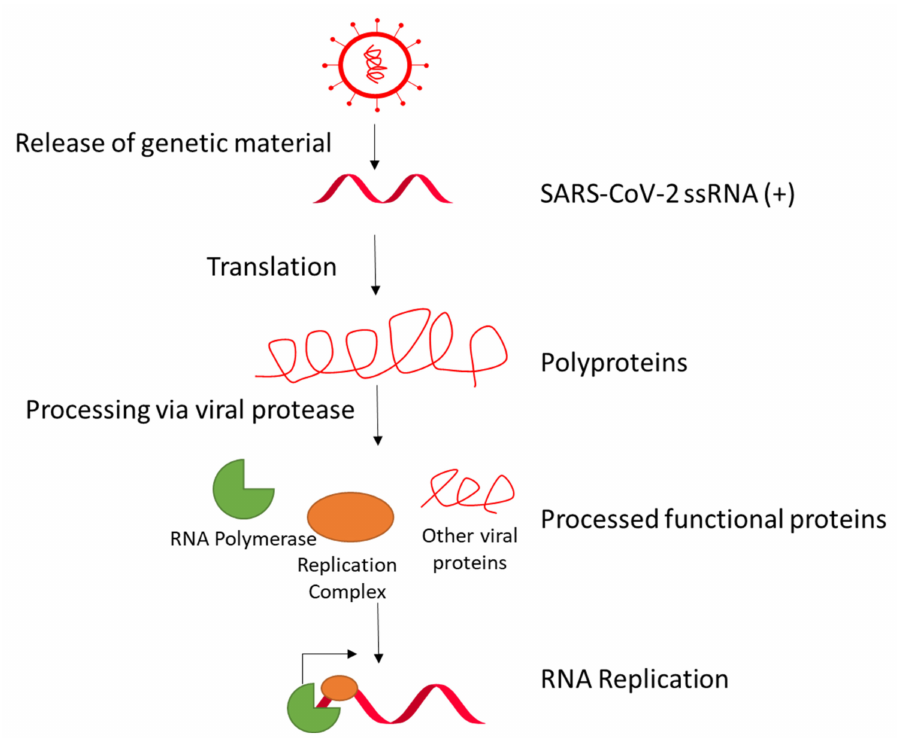
Figure 3. SARS-CoV-2 replication and viral protein translation. SARS-CoV-2 has ssRNA(+) as genetic material that is translated to polyproteins. The polyproteins are processed by viral proteases to generate more functional viral proteins; e.g., RNA-dependent RNA polymerase and replication complex for RNA